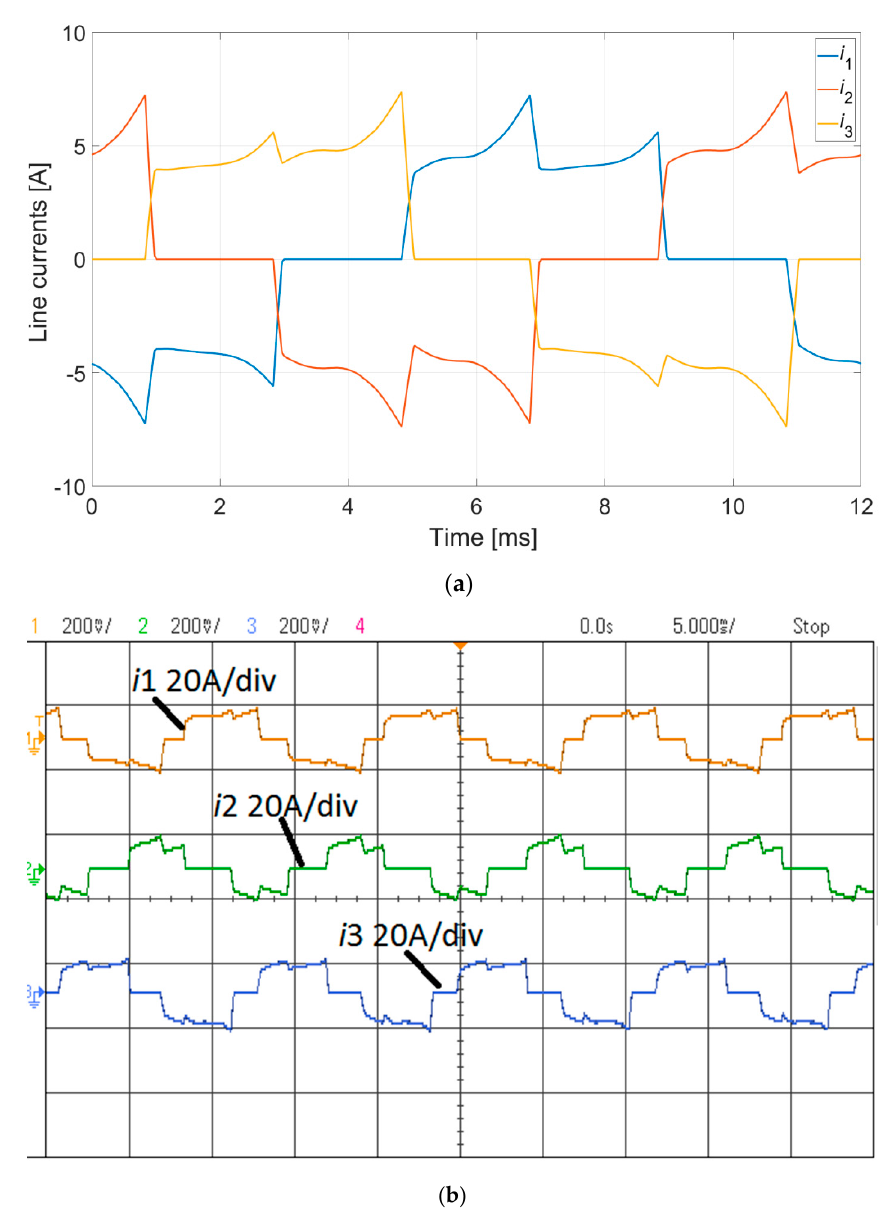
Figure 20. Star–delta (Y ∆ ) configuration—waveforms of line currents in fault state OC2: ( a ) numerical calculations; ( b ) measurements.